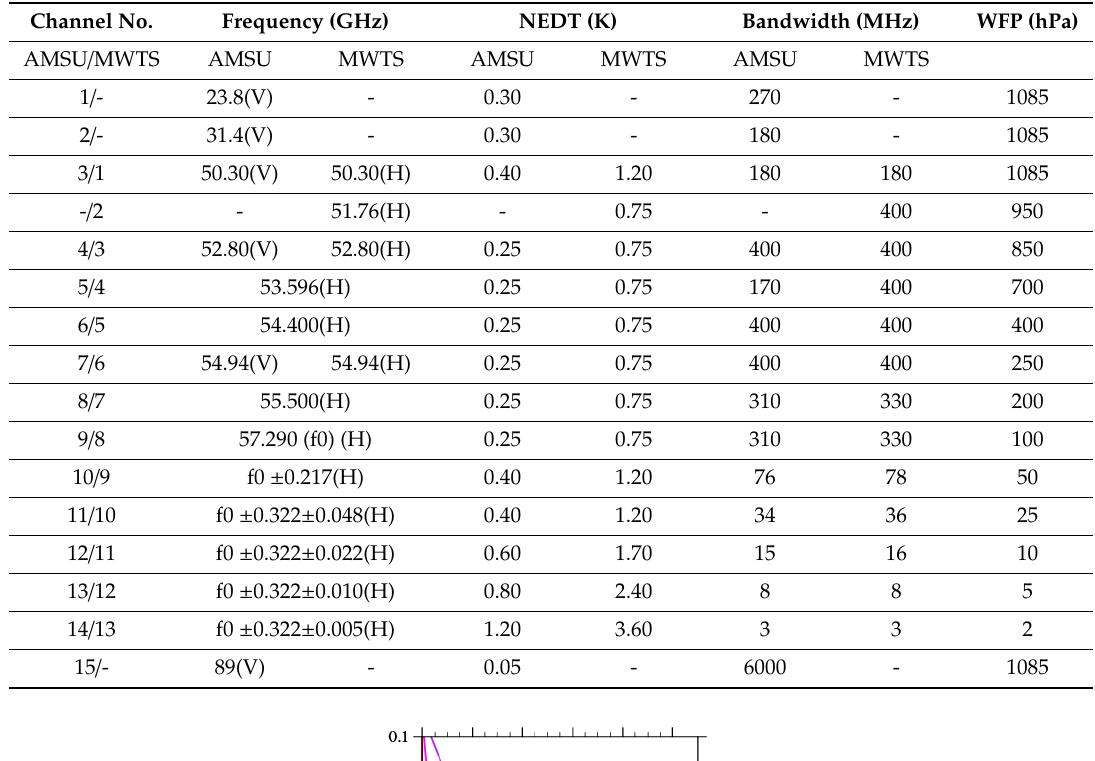
Table 1. Channel number, frequency, noise equivalent di ff erential temperature (NEDT), bandwidth, polarization, and weighting function peak (WFP) of MetOp-B Advanced Microwave Sounding Unit-A (AMSU-A) and Fengyun (FY)-3C MWTS-2. Channel No.